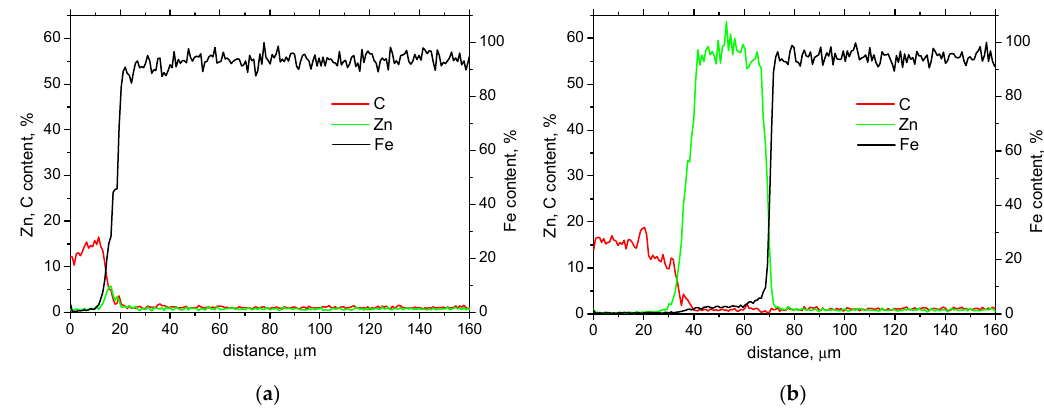
Figure 11. Linear chemical analysis of compacted wire: ( a ) position 1, ( b ) position 4.